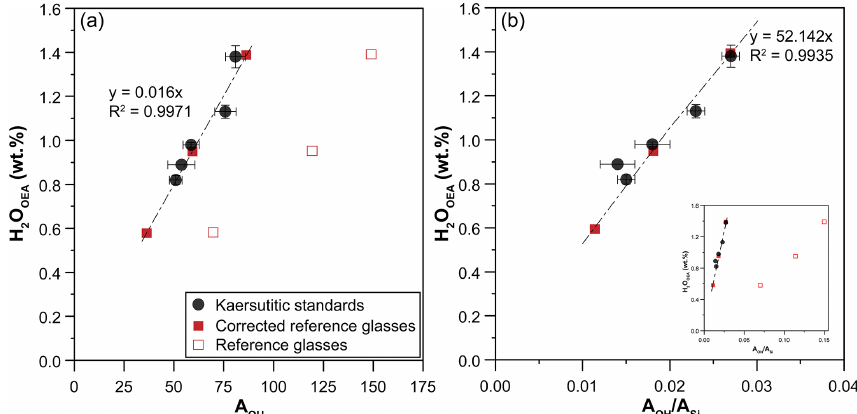
Figure 2. Calibration lines defined by kaersutitic amphiboles used as standards: correlation between water contents of amphibole determined by the OEA and (a) A OH or (b) A OH /A Si . The three reference glasses also used as external standards during all Raman sessions are plotted. The factors used to correct the intensities of the reference glasses are reported in Table